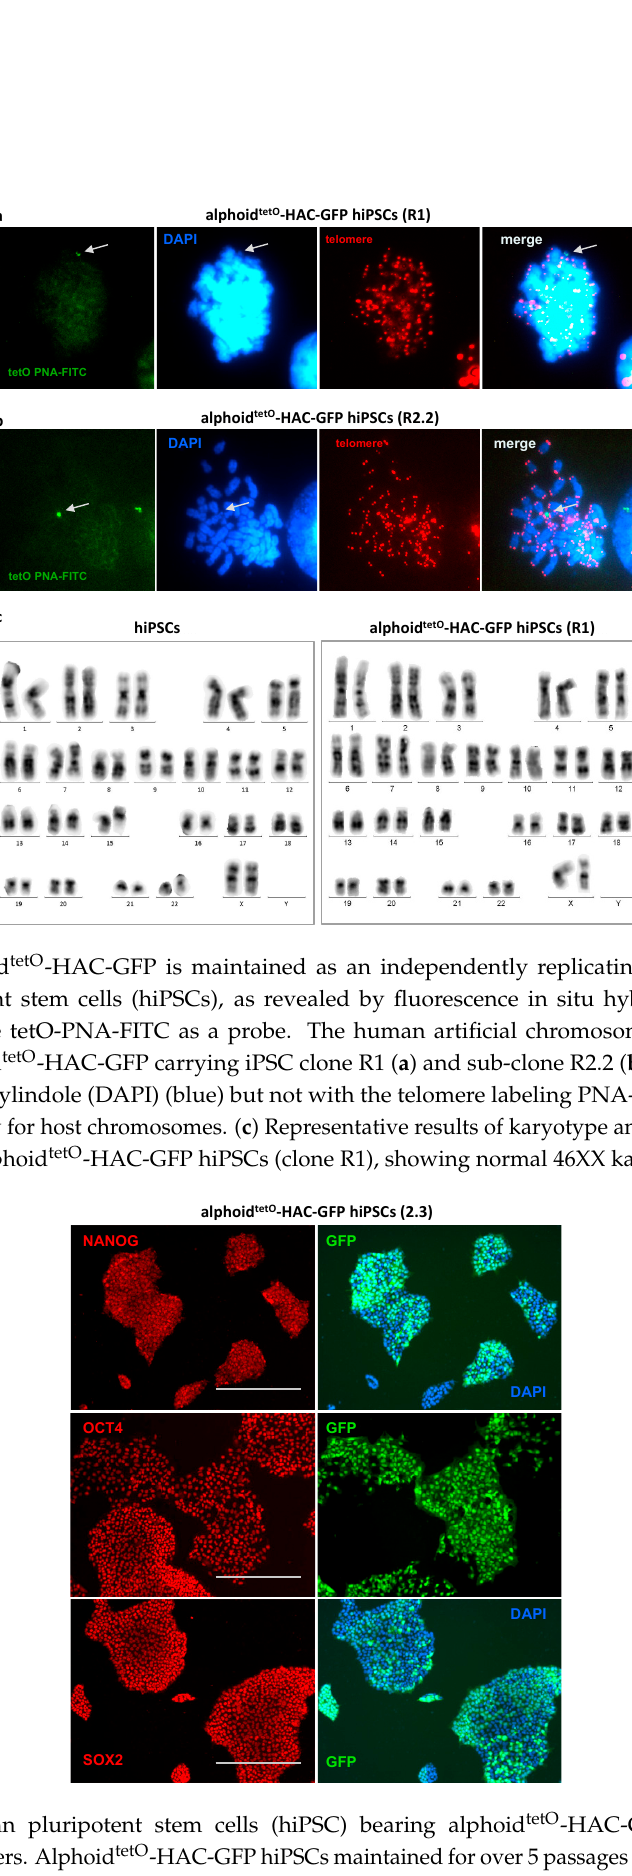
Figure 5. Human pluripotent stem cells (hiPSC) bearing alphoid tetO -HAC-GFP cells express pluripotency markers. Alphoid tetO -HAC-GFP hiPSCs maintained for over 5 passages remain pluripotent as they express OCT4, NANOG, and SOX2 markers (red), indicated on the panels. Scale bar, 400 μ m.